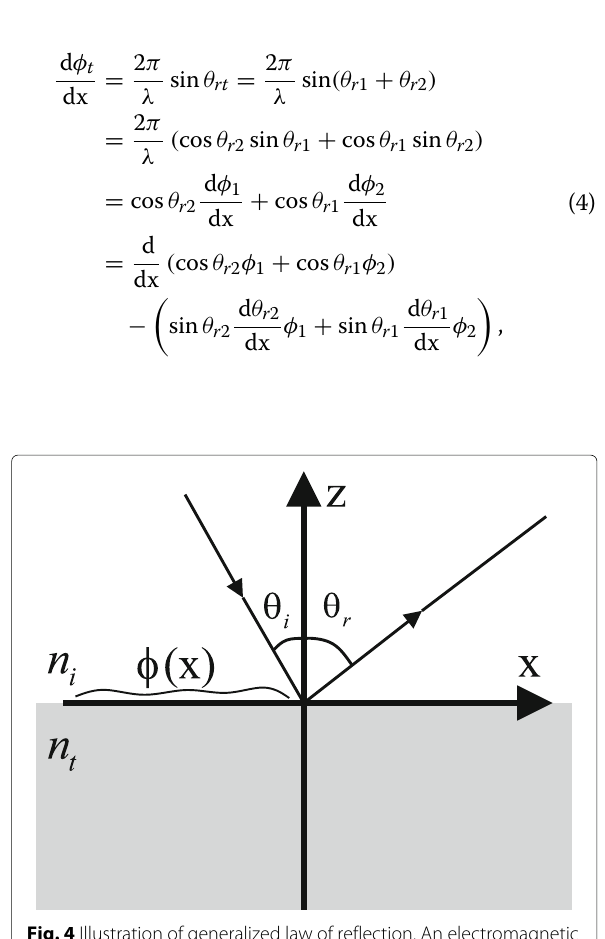
Fig. 4 Illustration of generalized law of reflection. An electromagnetic wave impinges from the top with incident angel θ i , while is reflected by θ r other than θ i , duetophasediscontinuity φ( x ) along the